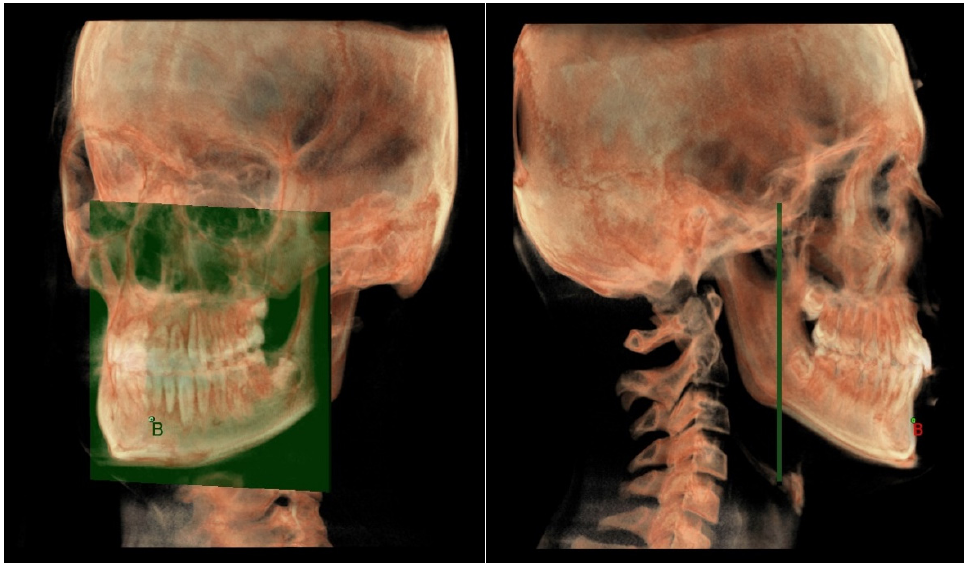
Figure 6. Maxillary skeletal arch in 3D analysis.